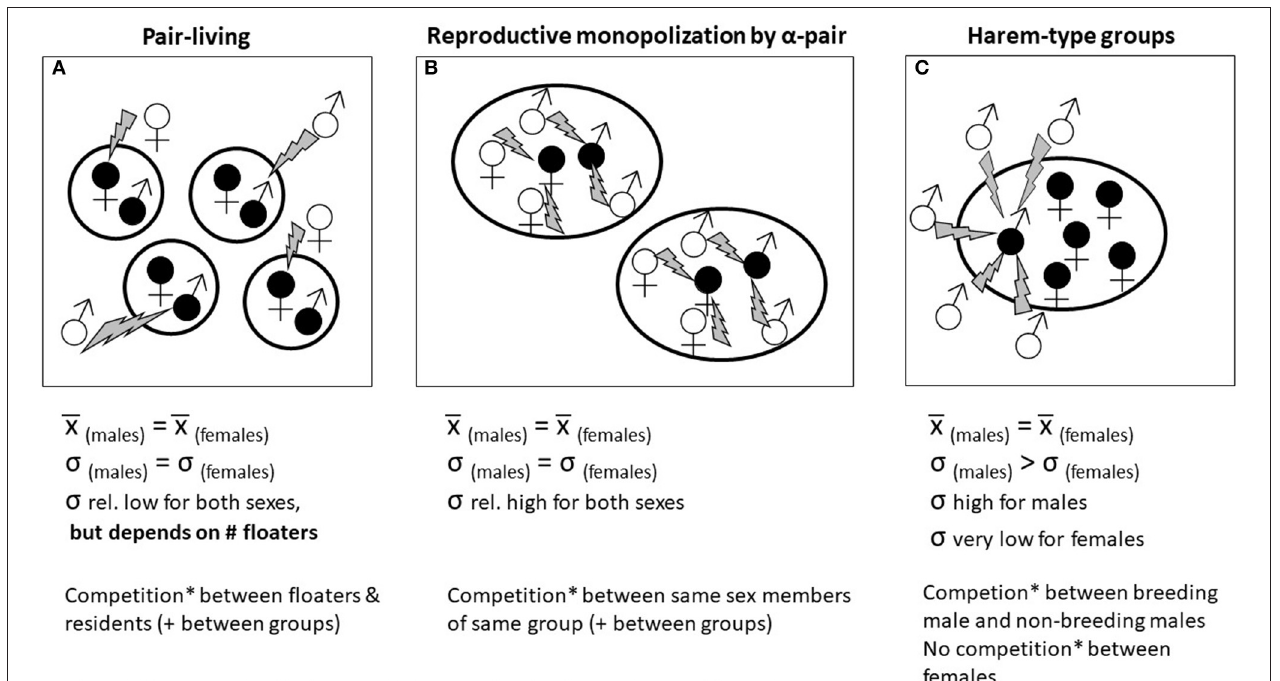
FIGURE 1 | Potential relationships between social organization and the variance in male and female reproductive success. Circles represent social groups. Filled symbols for males and females represent established breeders, while unfilled symbols represent other adult individuals. In all three scenarios there are six adult males and six adult females representing the population. Gray lightning bolts represent the potential for sexual competition (additional competition between individuals from different groups is additionally possible). An equal adult sex ratio is assumed. (A) In pair-living species, the majority of adults will live in established pairs. Competition is mainly between breeders established in groups and floaters. Variance of reproductive success is the same for males and females. How much variance in reproductive success exists depends on the relative number of floaters to established pairs, which in turn depends on the relative tenure length, reproductive rates of pairs, and mortality rate of floaters. (B) In group-living species with an alpha-breeding pair that monopolizes reproduction (possibly with monogamous mating system), the variance in reproductive success is again the same for both sexes, but with mature individuals in the same group that are (usually) not reproducing, the total variance is relatively high, with a high potential for same-sex competition within groups. Competition with potential intruders will depend on who the dispersing sex is, which in group-living species tends to be only one sex, with the exception of the callitrichines. (C) In more typical harem-type social organizations, female reproductive success within groups does not very much, while the variance amongst males is much